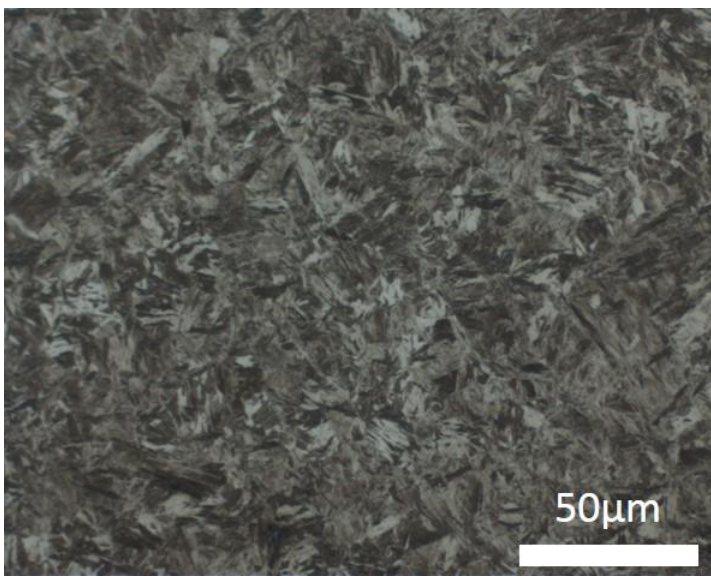
Figure 15. Martensitic microstructure of the material stamped at 2.5 MPa set-point and analyzed in LP zone.